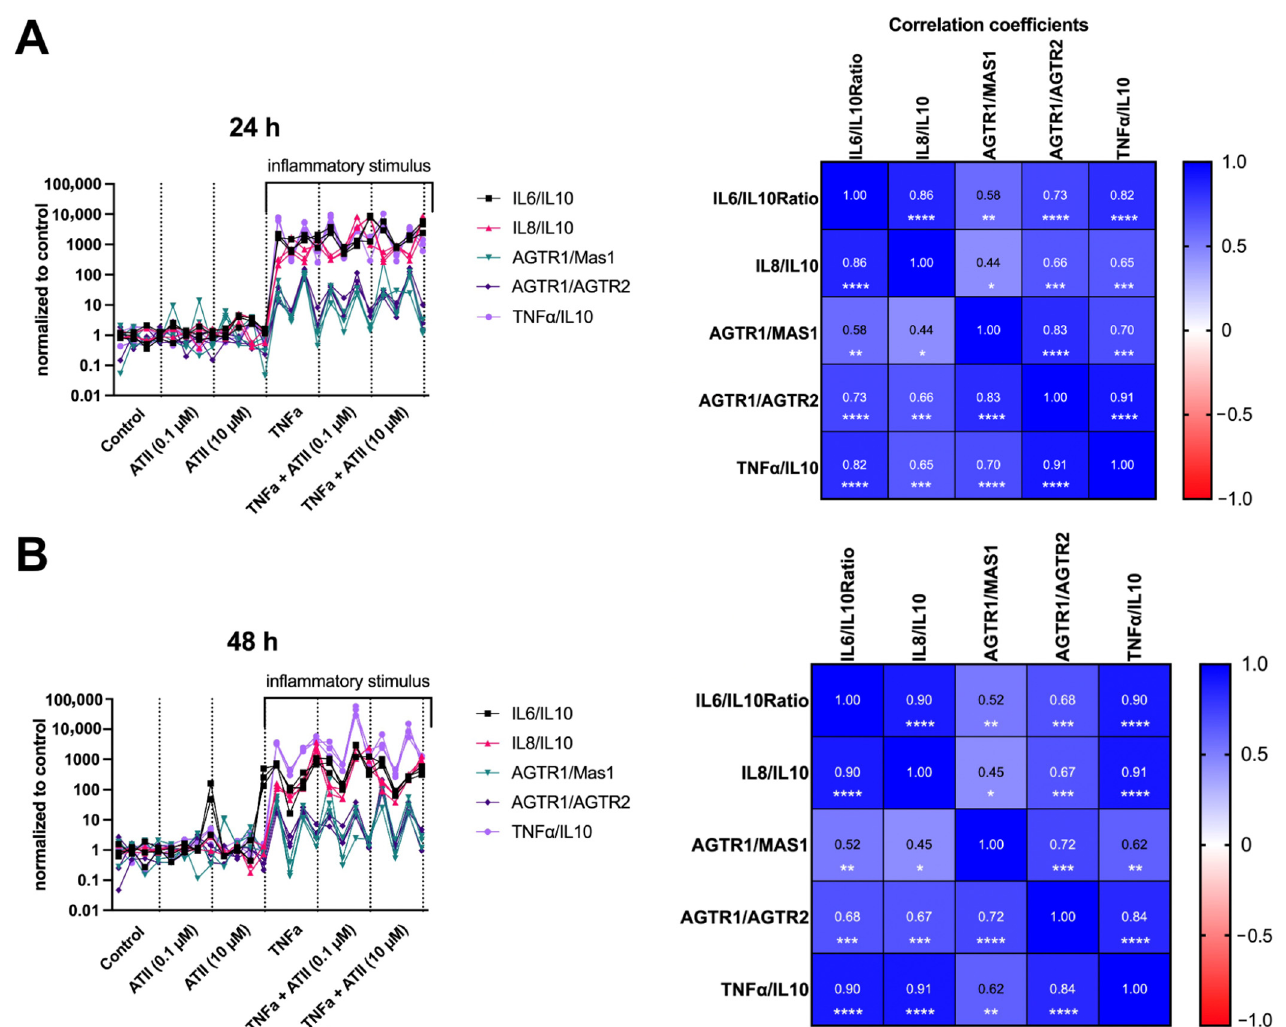
Figure 3. Illustration of tRAS axis ratios (AGTR1/AGTR2, AGTR1/MAS1) [11] and inflammatory to anti-inflammatory gene expression markers (Il-6/IL-10, IL-8/IL-10, and TNF- α /IL-10) after 24 h ( A ) and 48 h ( B ) of drug or control exposure. Ratios of pro-inflammatory to anti-inflammatory markers are indicators for the inflammatory state of the intervertebral disc and low back pain [38,39]. AGTR1/AGTR2 and AGTR1/MAS1 gene expression ratios were positively correlated with the pro- inflammatory/anti-inflammatory marker ratios Il-6/IL-10, IL-8/IL-10, and TNF- α /IL-10. Spear- man correlation coefficients are shown in the matrix. Fold change values obtained from the 2ˆ( − DeltaDeltaCt) method and normalized to the baseline (day 0) are shown. n = 4 biological replicates and n = 3 technical replicates per donor were assessed. Inflammatory stimulus indicates the groups exposed to TNF- α . Correlation of ratios was assessed by taking the mean from the technical replicates for each group of the respective donors and calculating the correlation coefficient between the ratios ( n = 24 per ratio; 4 donors x 6 groups (with the mean used for the three technical replicates per group). Lines are connected for better visual differentiation between the ratios. Each symbol represents one replicate per group and donor. * p < 0.05; ** p < 0.01; *** p < 0.001; **** p <